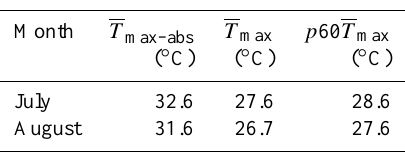
Table 3. Most significant flash heat episodes affecting Barcelona since 1780. Note that on 27 of August 2010, the maximum tem- perature was 39.3 ◦ C (24 ◦ C in the early morning and 26 ◦ C in the evening). T 12– and T 12+ indicate the temperature 12h before and after the maximum temperature recorded ( T max ),